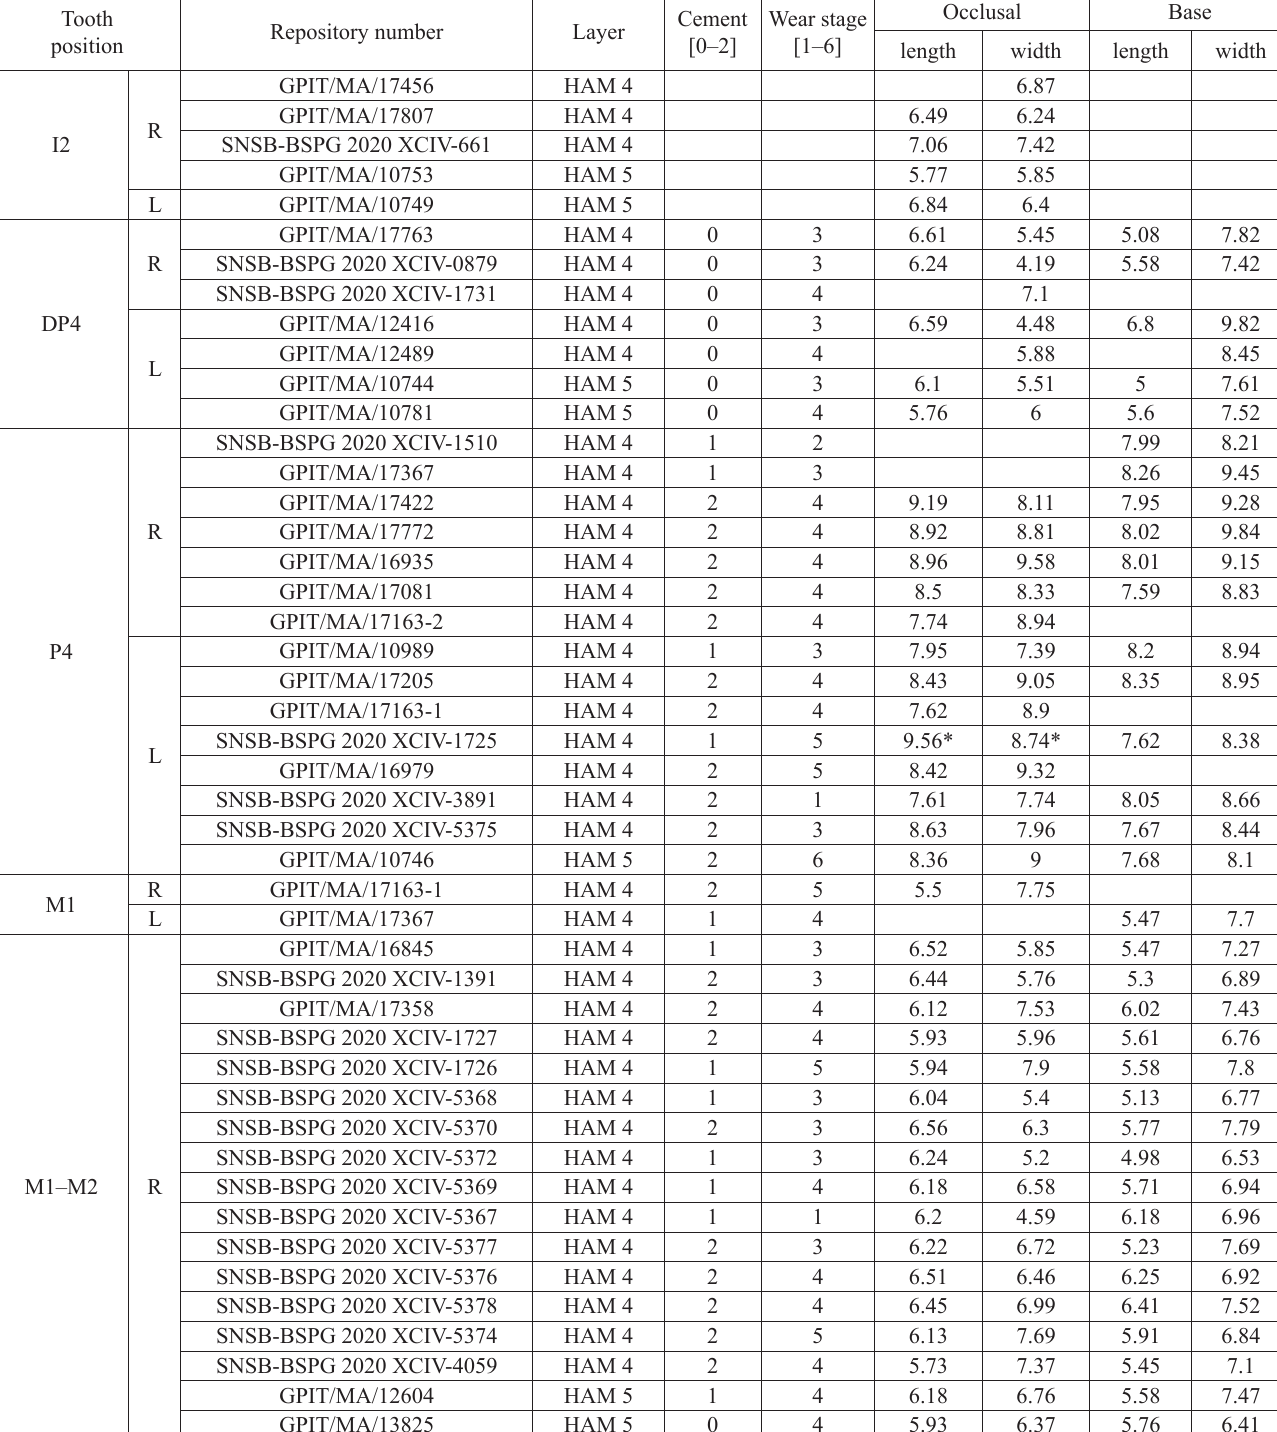
Table 2. Material list with dimensions (in mm) of upper and lower teeth of the beaver Steneofiber depereti Mayet, 1908, from the early Late Miocene locality Hammerschmiede (Bavaria, Germany) and the local stratigraphic levels HAM 5 and HAM 4. L, left; R, right. Cement codes the occurrence of cement filling in cheek teeth flexids with (0) no cement, (1) first, faint traces of cement, and (2) complete filling with cement; wear stages are defined as (1), unworn: no wear can be observed, deciduous dentition in use, (2) slightly worn: first occlusal contact, (3) worn: para/metaflexus/-id is closing or just closed, (4) medium worn: mesoflexus/-id is closing or just closed, (5) deeply worn: hypoflexus/-id is near to closing, (6) heavily worn: hypoflexus/-id is closed; length occlusal, mesio-distal length at occlusal surface of cheek teeth and length across anterior enamel band for incisors; length at base, mesio-distal length at basal tooth position (where possible); width occlusal, bucco-lingual width at occlusal surface of cheek teeth and incisors; width at base, bucco-lingual width at basal tooth position (where possible). Estimated values of measurements are marked by an asterisk